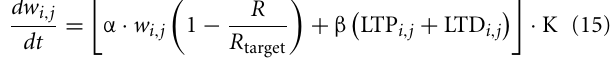
Table 2 | Sorted fitness values (higher is better) for the initial and final SNN populations.